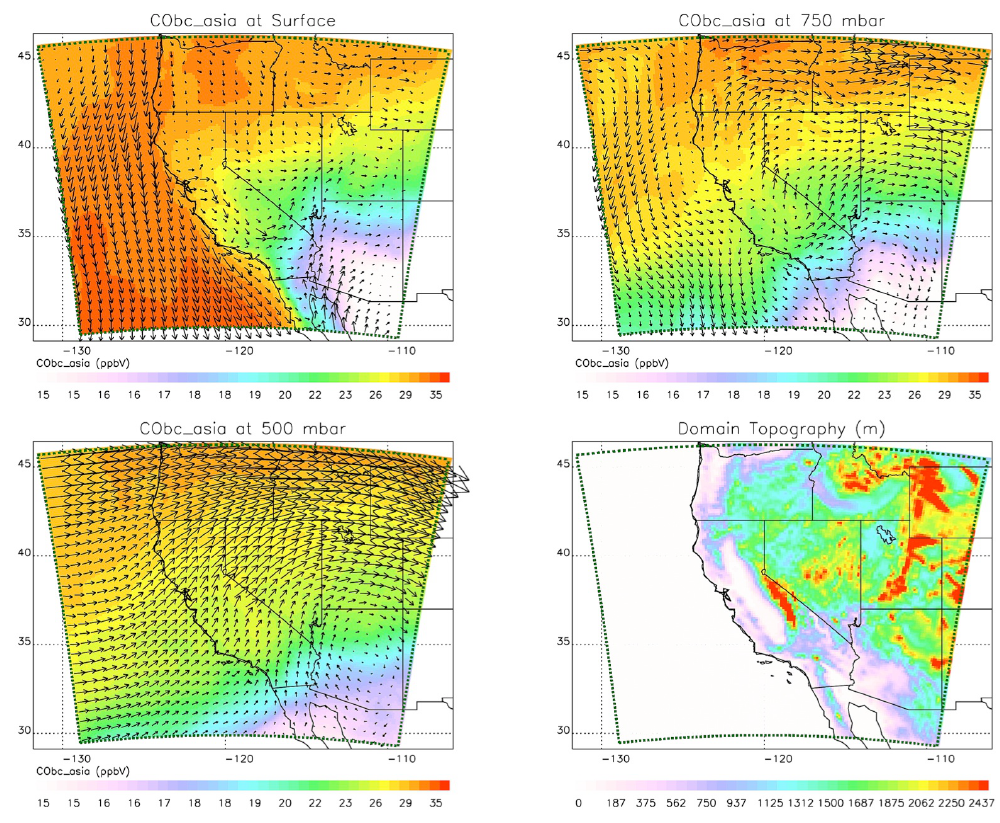
Fig. 9. Average CObc asia mixing ratios and wind fields for 20 June–15 July at the surface, 750mbar ( ∼ 1.6km) and 500mbar ( ∼ 4km) model levels. The domain topography is shown in the bottom right